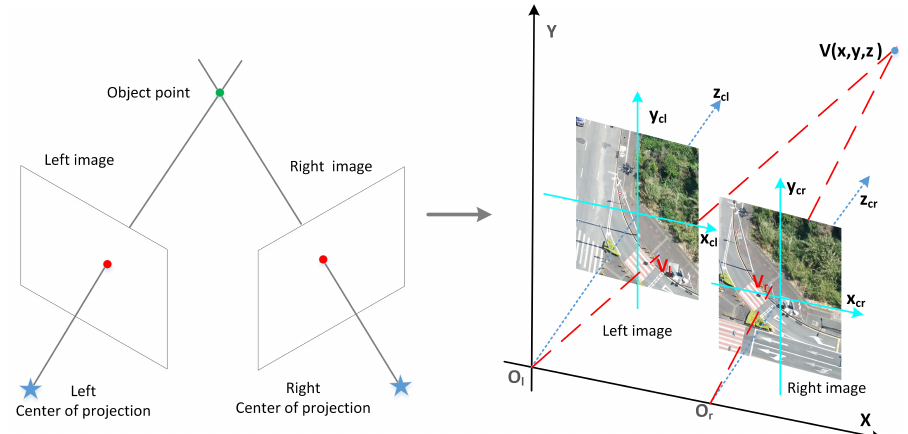
Figure 6. Structure from stereo vision. A pair of corresponding points V l and V r are used to obtain a 3D point via triangulation.